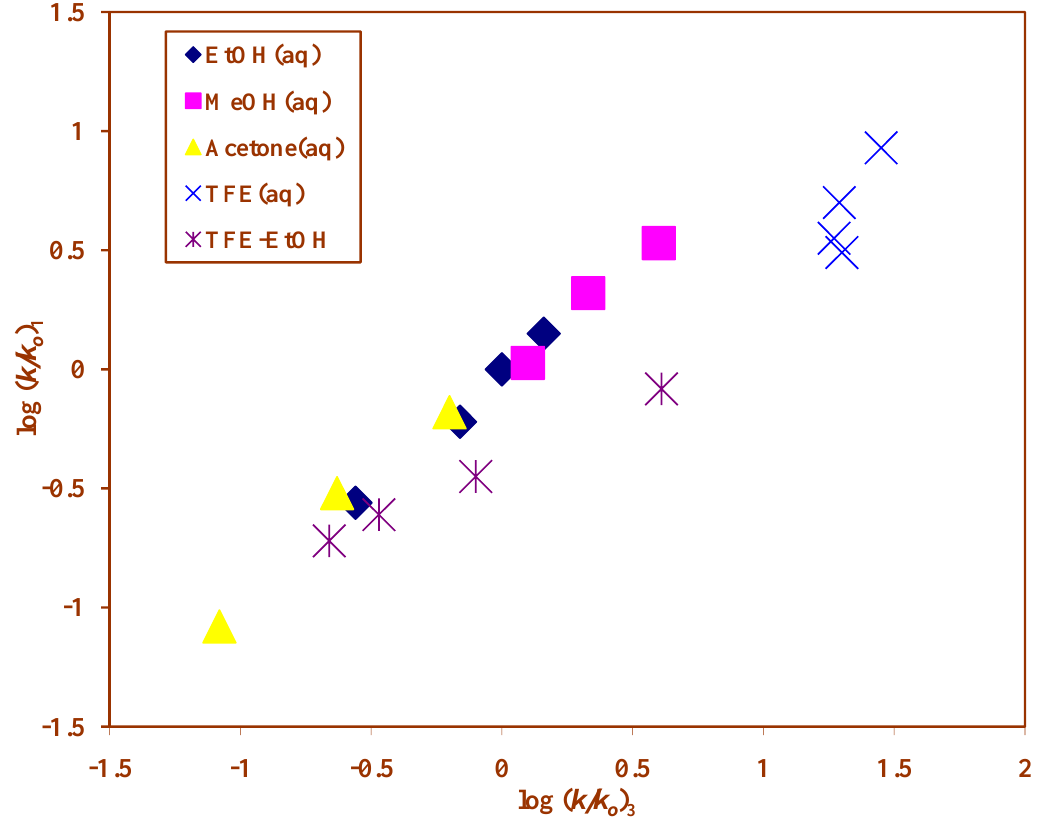
Figure 3 . The plot of log ( k/k adamantyl chloroformate ( 3 ) in pure and binary solvents at 25.0